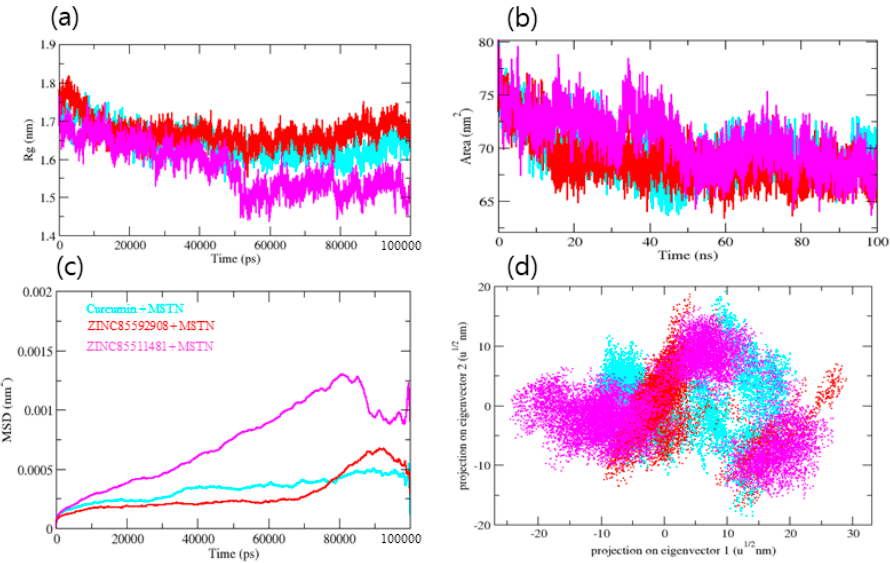
Figure 4. ( a ) Radius of gyration, ( b ) SASA of MSTN protein, ( c ) MSD (Mean square displacement) of MSTN protein, ( d ) Two dimensional projection of MSTN protein.